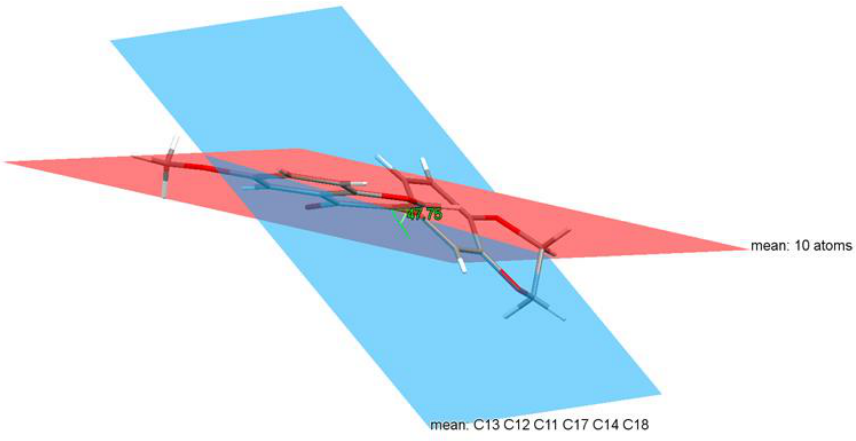
Figure 2. Dihedral angle formed between the plane of the chromenone ring (red) and benzene ring (blue).